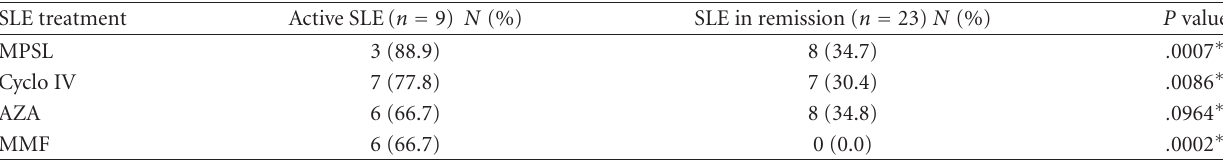
Table 2: SLE treatment at the time of Zoster infection in relation to SLE activity.